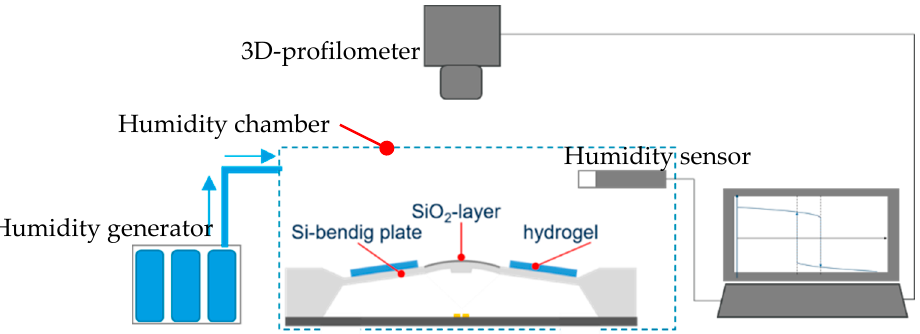
Figure 15. Set-up comprising the humidity chamber, the humidity sensor, and the humidity generator.